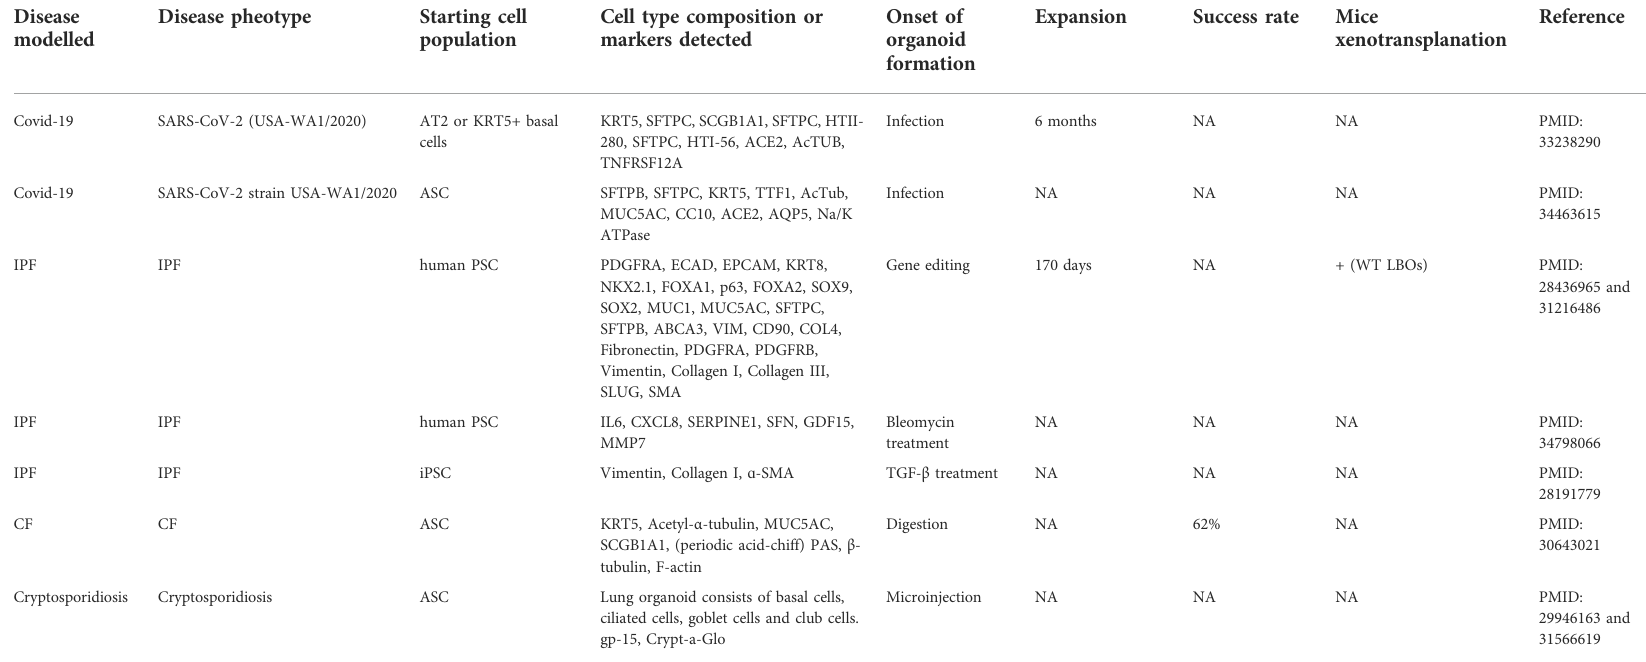
TABLE 1 ( Continued ) Key studies of lung disease model using